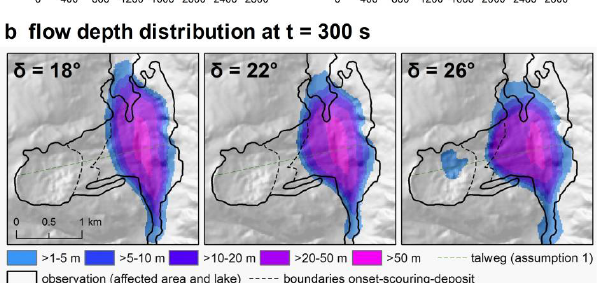
Fig. 10: (a) Longitudinal profiles of the flow at different time steps with φ = 35°: comparison Fig. 10. (a) Longitudinal profiles of the flow at different time steps of the results with δ = 18, 22 and 26° with a cell size of 20 m – the flow depth for δ = 22° is with φ = 35 ◦ : comparison of the results with δ = 18, 22 and 26 ◦ with a cell size of 20m – the flow depth for δ = 22 ◦ is also shown also shown proportionally to the terrain; (b) flow depth distribution at t = 300 s, computed proportionally to the terrain; (b) flow depth distribution at t = 300s, with three different assumptions of δ . computed with three different assumptions of δ